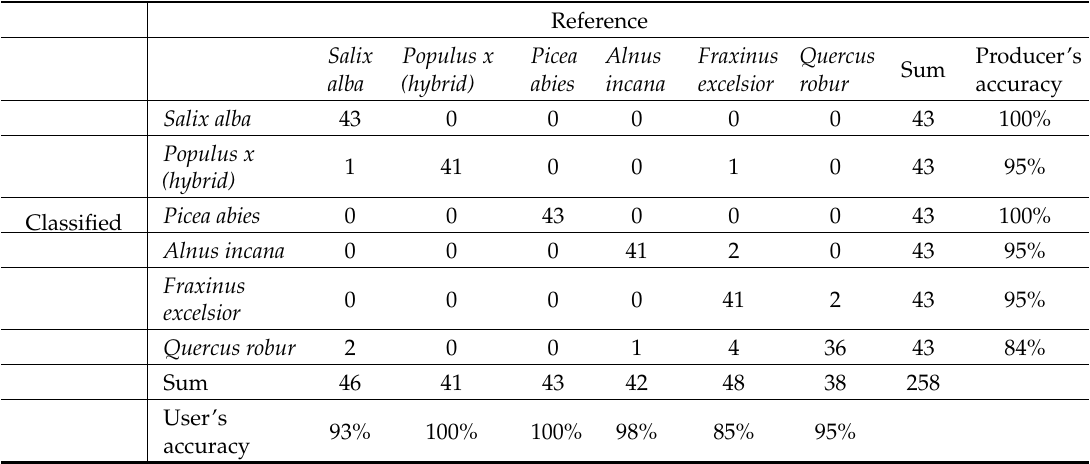
Table A4. The accuracy assessment using the MNF data cube (with 35 components) as an input to the RF algorithm.